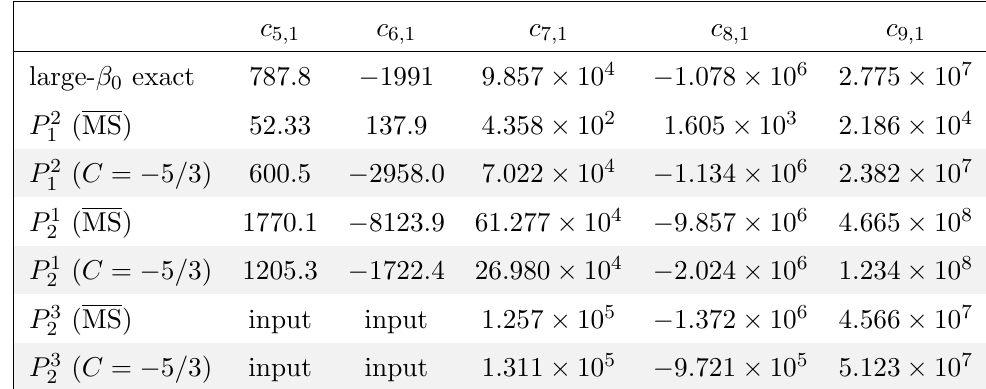
Table 1. Coe(cid:14)cients of the Adler function in the large- (cid:12) 0 approximation in the MS scheme. The (cid:12)rst row gives the exact values. Darker rows show the results obtained from P 2 constructed in a scheme with C = (cid:0) 5 = 3 and later evolved to MS using eq. (4.15). For comparison, we also display the results obtained through the use of these PAs constructed directly in the MS (second, fourth and sixth